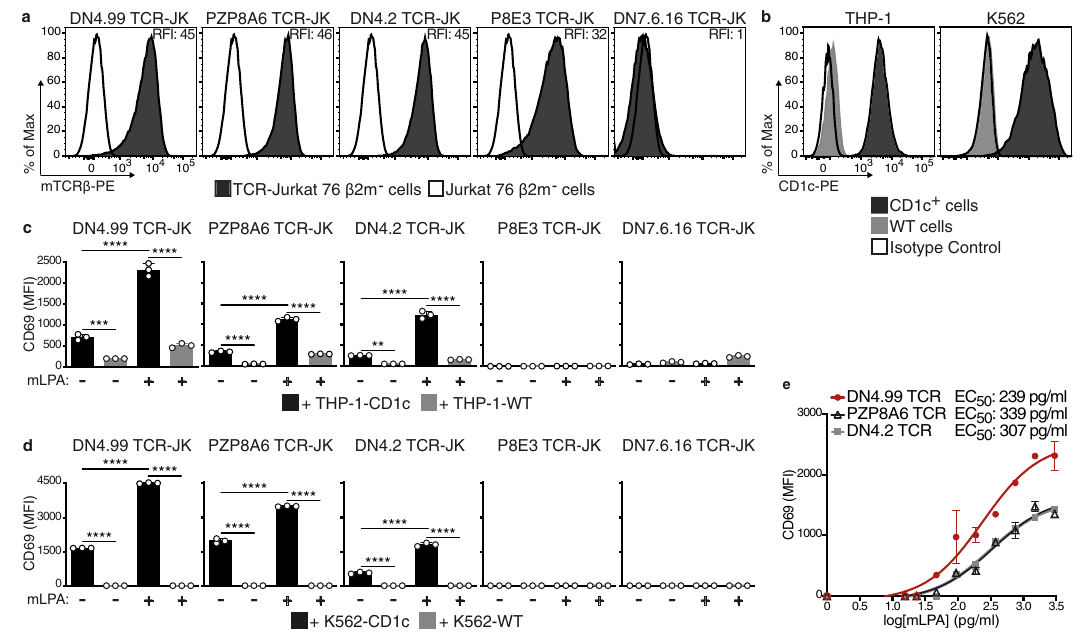
Fig. 2 Identi fi cation of the lead CD1c-restricted mLPA-speci fi c TCR to target acute leukemia. Chimeric human V-mouse C TCR chains obtained from the indicated CD1c self-reactive T cell clones 10 followed by IRES and the GFP-coding sequence were cloned into lentivectors and transduced into Jurkat (JK) cells. Transduced JK cells were sorted to have comparable TCR expression. a TCR expression on transduced (black histograms) and non-transduced (white histograms) JK cells determined by fl ow cytometry labeling with anti-mouse TCR β (mTCR β ) monoclonal antibody (mAb). Relative fl uorescence Intensity (RFI) was calculated as the ratio between the intensity of labeling on transduced and non-transduced JK cells. b Flow cytometry detection of CD1c expression on CD1c + (black histograms) and wt (gray histograms) THP-1 and K562 cells labeled with anti-human CD1c mAb. White histograms represent labeling with isotype-matched control mAb. c , d TCR-JK cells recognize CD1c + leukemia cells. TCR-JK cells were cultured overnight with THP-1-CD1c ( c )